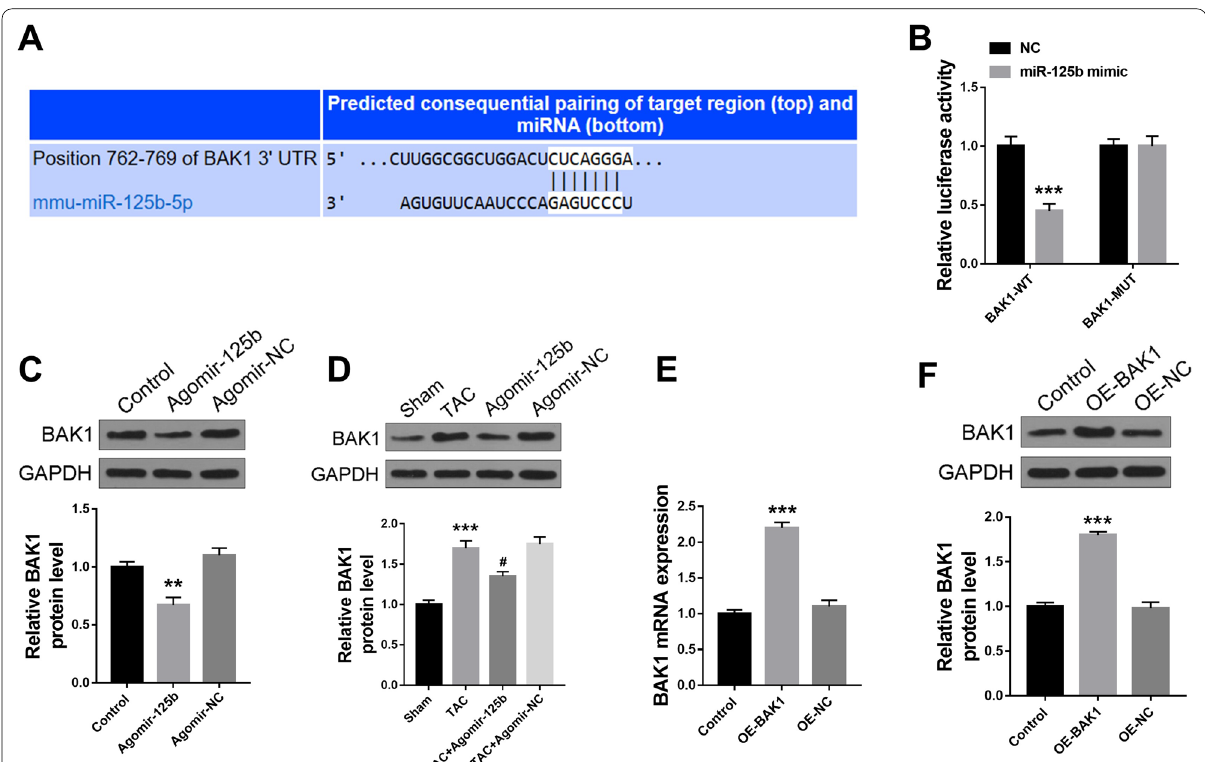
Fig. 4 BAK1 was a target of miR-125b. A The putative binding sites between miR-125b and 3 ′ UTR of BAK1 was predicted by Targetscan database. B The relative luciferase activity in HEK293T cells was evaluated by dual luciferase report system (n 6). *** p < 0.001 vs. miR-NC group. C Agomir-125b = or agomir-NC was tail intravenously injected into normal mice, and the protein expression of BAK1 was evaluated by Western blot (n 5). ** p < 0.01, = *** p < 0.001 vs. control group. D Agomir-125b or agomir-NC was tail intravenously injected into TAC mice, and the protein expression of BAK1 was evaluated by Western blot (n 5). ** p < 0.01, *** p < 0.001 vs. sham group. E and F OE-BAK1 or OE-NC was tail intravenously injected into normal = mice, then mRNA expression ( E ) and protein expression ( F ) was evaluated